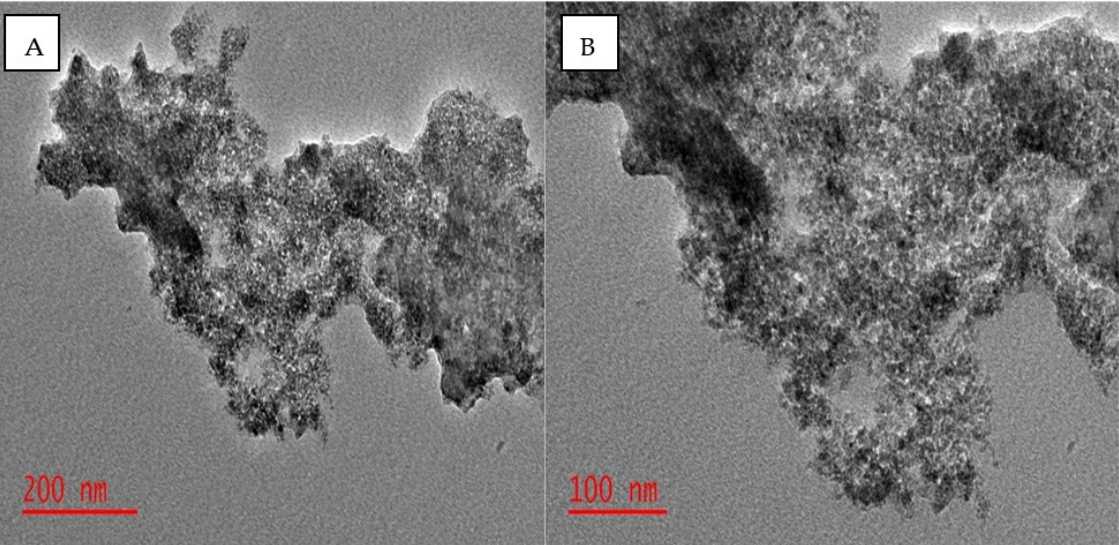
Figure 2. Transmission electron microscopy images of β -cyclodextrin magnetic activated carbon adsorbent at different magnifications: ( A ) 200 nm and ( B ) 100 nm.